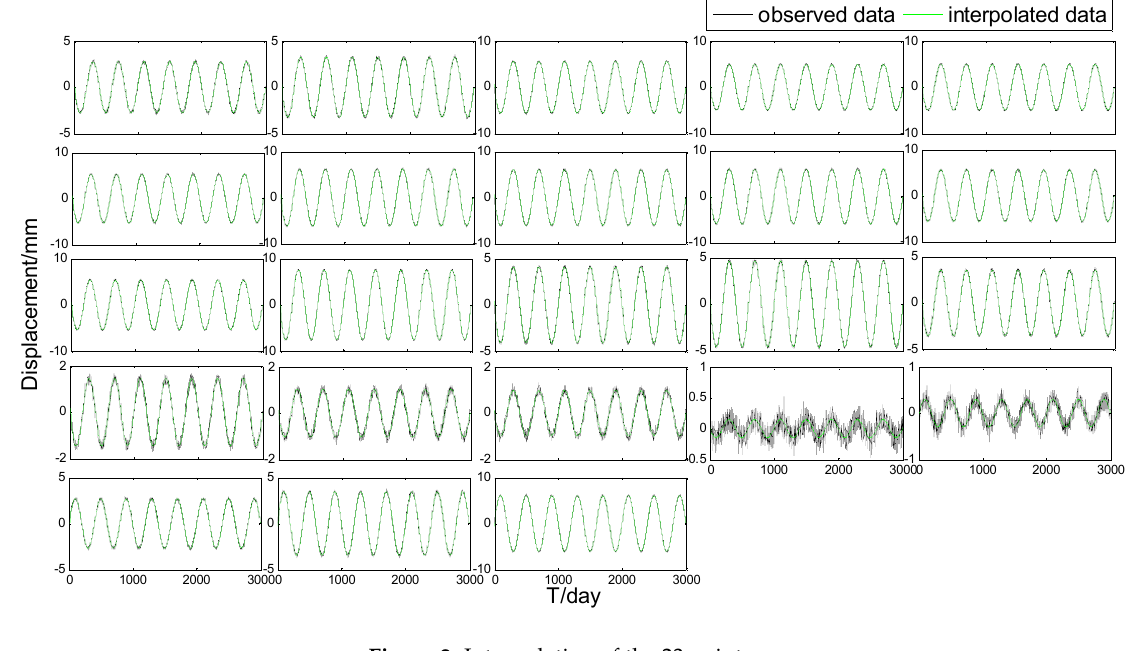
Figure 2. Interpolation of the 23 points. Table 1. RMS 1 of Interpolation, Filter, and Prediction of each point (unit: mm). Interp, Interpolation; Pred,